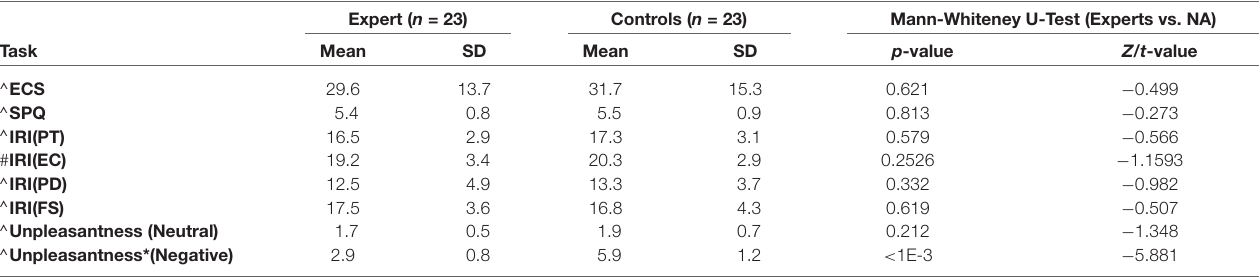
TABLE 2 | Dispositional measurement of empathy and ratings of unpleasantness in the acupuncturist and NA groups . Expert ( n = 23) Controls ( n = 23) Mann-Whiteney U-Test (Experts vs.